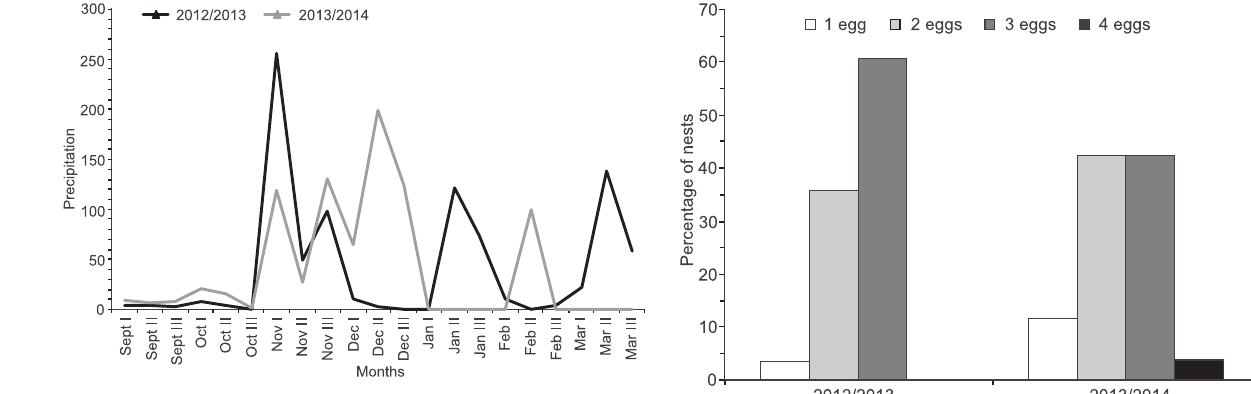
Figure 3. Mean 10-day rainfall in millimeters (mm) from 2012 to 2014 in the Municipality of Guarapari, southeastern Brazil. Roman letters indicate 10-day periods of each month: I = from day 1 to 10; II = from day 11 to 20; III = from day 21 to 30 (or 31). (Source: Instituto Capixaba de Pesquisa, Assistência Técnica e Extensão Rural – INCAPER).